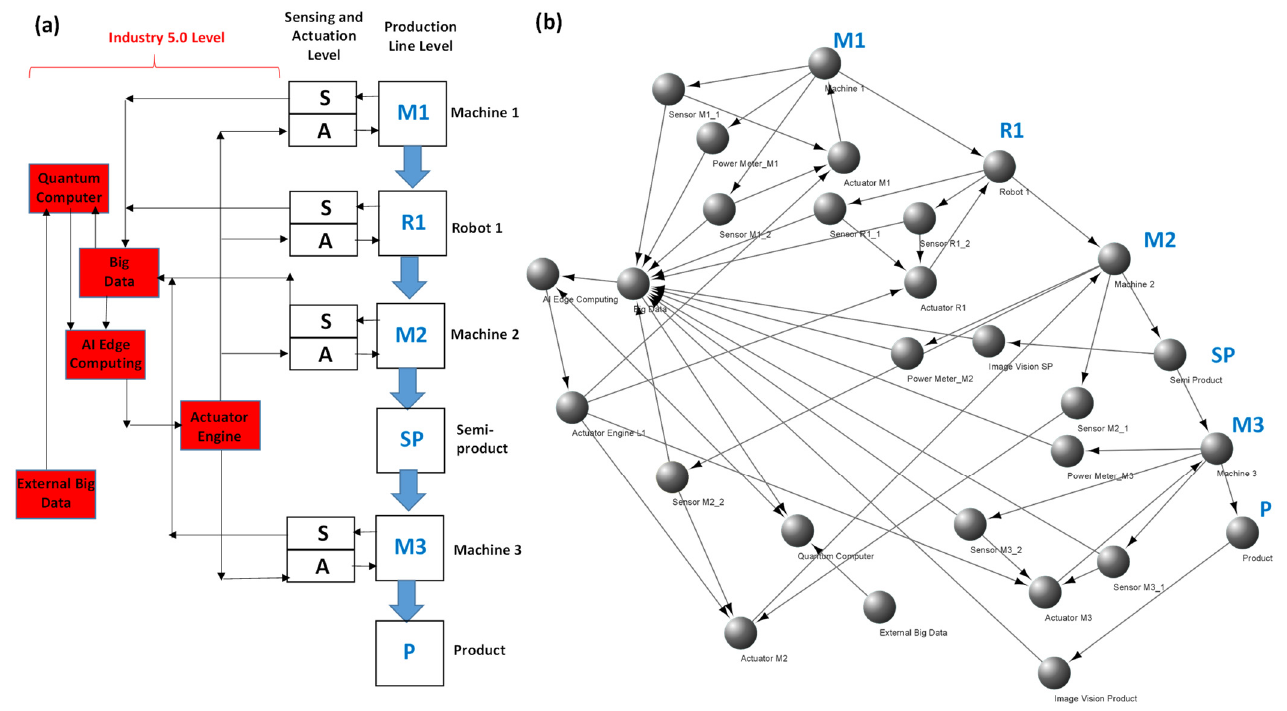
Figure 3. ( a ) Simplified Industry 5.0 framework differentiating three main levels of the processing of a manufacturing workpiece: production line level, sensing and actuation level, and Industry 5.0 level. ( b ) Cytoscape complex model simulating the Industry 5.0 framework.